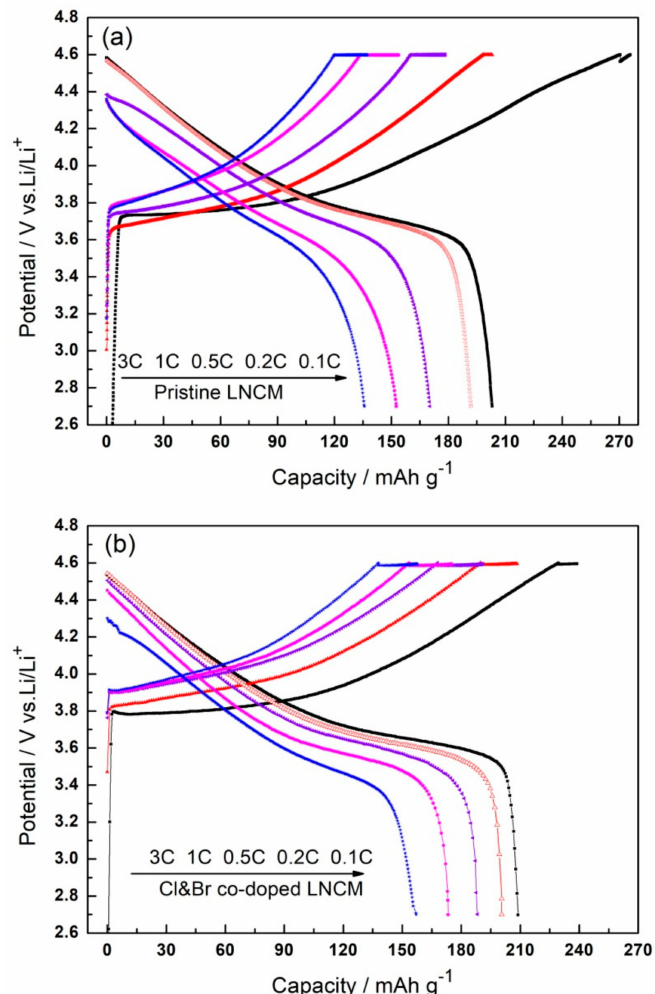
Figure 4. Initial charge and discharge capacities of the synthesized LiNi 1/3 Co 1/3 Mn 1/3 O 2 compounds at 0.1~3C: ( a ) Pristine LNCM; ( b ) Cl&Br co-doped